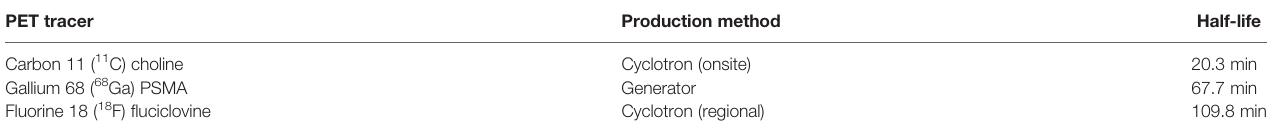
TABLE 2 | Summary of top PET imaging tracers for prostate cancer. PET